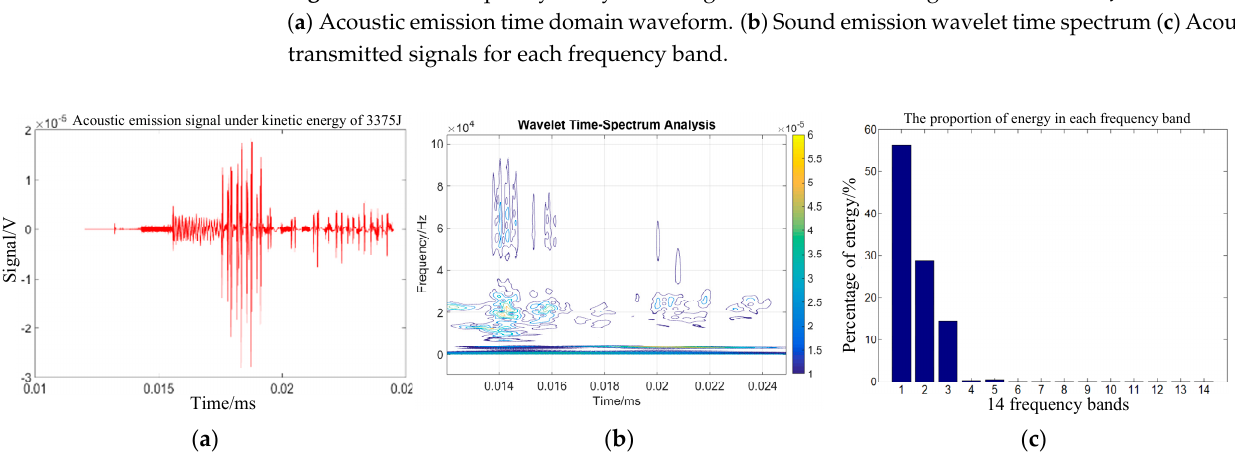
Figure 6. Time-frequency analysis of target sound emission signals under 4860 J. ( a ) Acoustic emi- sion time domain waveform. ( b ) Sound emission wavelet time spectrum. ( c ) Acoustic transmitted signals for each frequency band. Figures 3c, 4c, 5c and 6c show that the signal energy proportion in the frequency bands of 0–62.5, 62.5–125, 125–187.5, and 187.5–250 kHz is the highest, and the energy proportion is concentrated in the 250 kHz frequency band. With increasing initial kinetic energy, the acoustic emission signal frequency increases to a high frequency. As mentioned above, the difference of acoustic emission signals corresponding to different impact kinetic energy is predominantly concentrated in the energy difference of the high- frequency band within 250 kHz, that is, the signal analysis of the first three frequency bands after wavelet decomposition. To quantitatively analyze the differences in acoustic emission signals of target penetration under fragment velocity damage, the total energy and typical fragment kinetic energy of acoustic emission signals in the frequency ranges of 62.5–125, 125–187.5, and 187.5–250 kHz decomposed using wavelet were statistically analyzed. The mathematical relationship of typical evasion initial kinetic energy and sound emission wavelet total energy was determined. Figure 7 shows the wavelet energy of the evasion hit signal with speed change, based on the statistical method to fit the evaluation and wavelet energy shown in Equation (17).